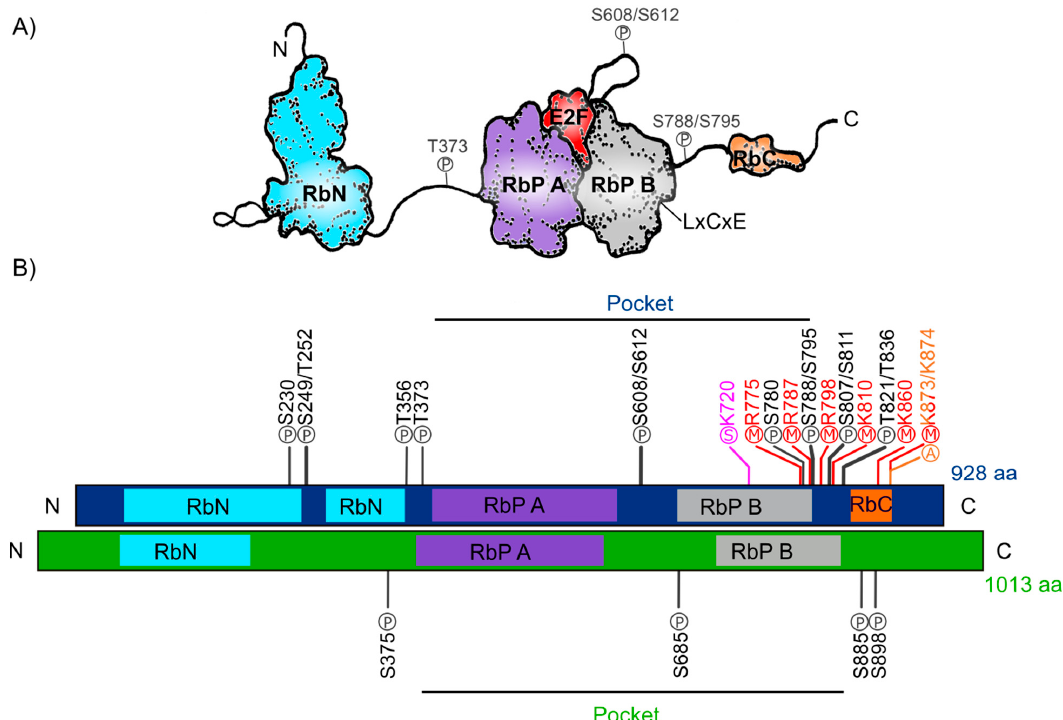
Figure 1. Retinoblastoma protein structure. ( A ) Representation of the human Rb protein structure with the domains RbN (blue), Pocket (RbP), with the RbP A (purple) and B (grey) subdomains interacting with an E2F TF (red), the RbC domain (orange) and the inter-domains (black lines) are also shown. The “P” inside a circle represents three examples of phosphorylation sites that change the structure of the protein. The position of the LxCxE cleft that allows Retinoblastoma protein (pRb) to interact with di ff erent proteins is also shown. ( B ) Comparison of the domains of human Rb protein (blue foreground) and Arabidopsis RBR protein (green foreground) and their reported post-translational modifications. Phosphorylation sites (P) are shown in black, methylation sites (M) in red, acetylation sites (A) in orange, and sumoylation sites (S) in